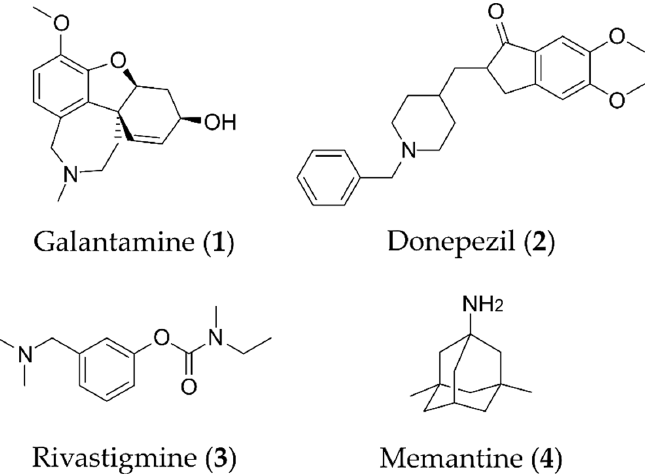
Figure 1. Structures of currently FDA-approved drugs for the treatment of AD, galantamine ( 1 ), donepezil ( 2 ), rivastigmine ( 3 ) and memantine ( 4 ). Donepezil and memantine are also approved as a combination therapy.